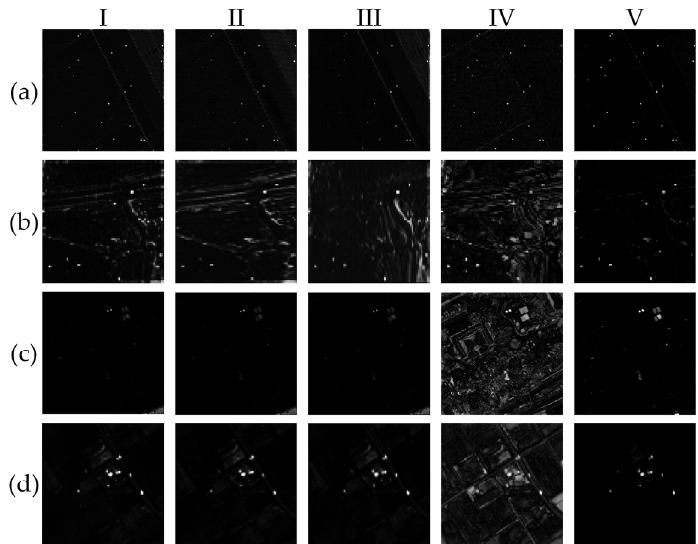
Figure 16. Detection results of different dimensions. Each row represents the detection results of different dimensions on a dataset. Each column represents the detection results of the same dimension on different datasets: ( a ) synthetic dataset; ( b ) urban dataset; ( c ) MUUFL Gulfport dataset; ( d ) Chikusei dataset; ( I ) dimension 1; ( II ) dimension 2; ( III ) dimension 3; ( IV ) dimension 4; ( V ) final results.